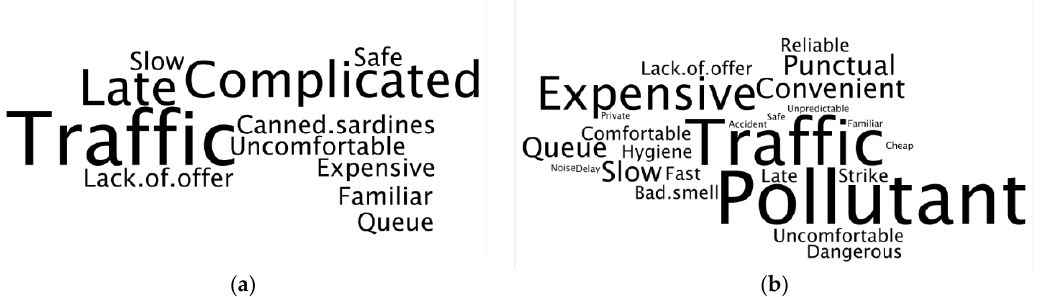
Figure 1. ( a ) Word cloud of road transport inside Lisbon municipality; ( b ) Word cloud of road transport outside Lisbon municipality.